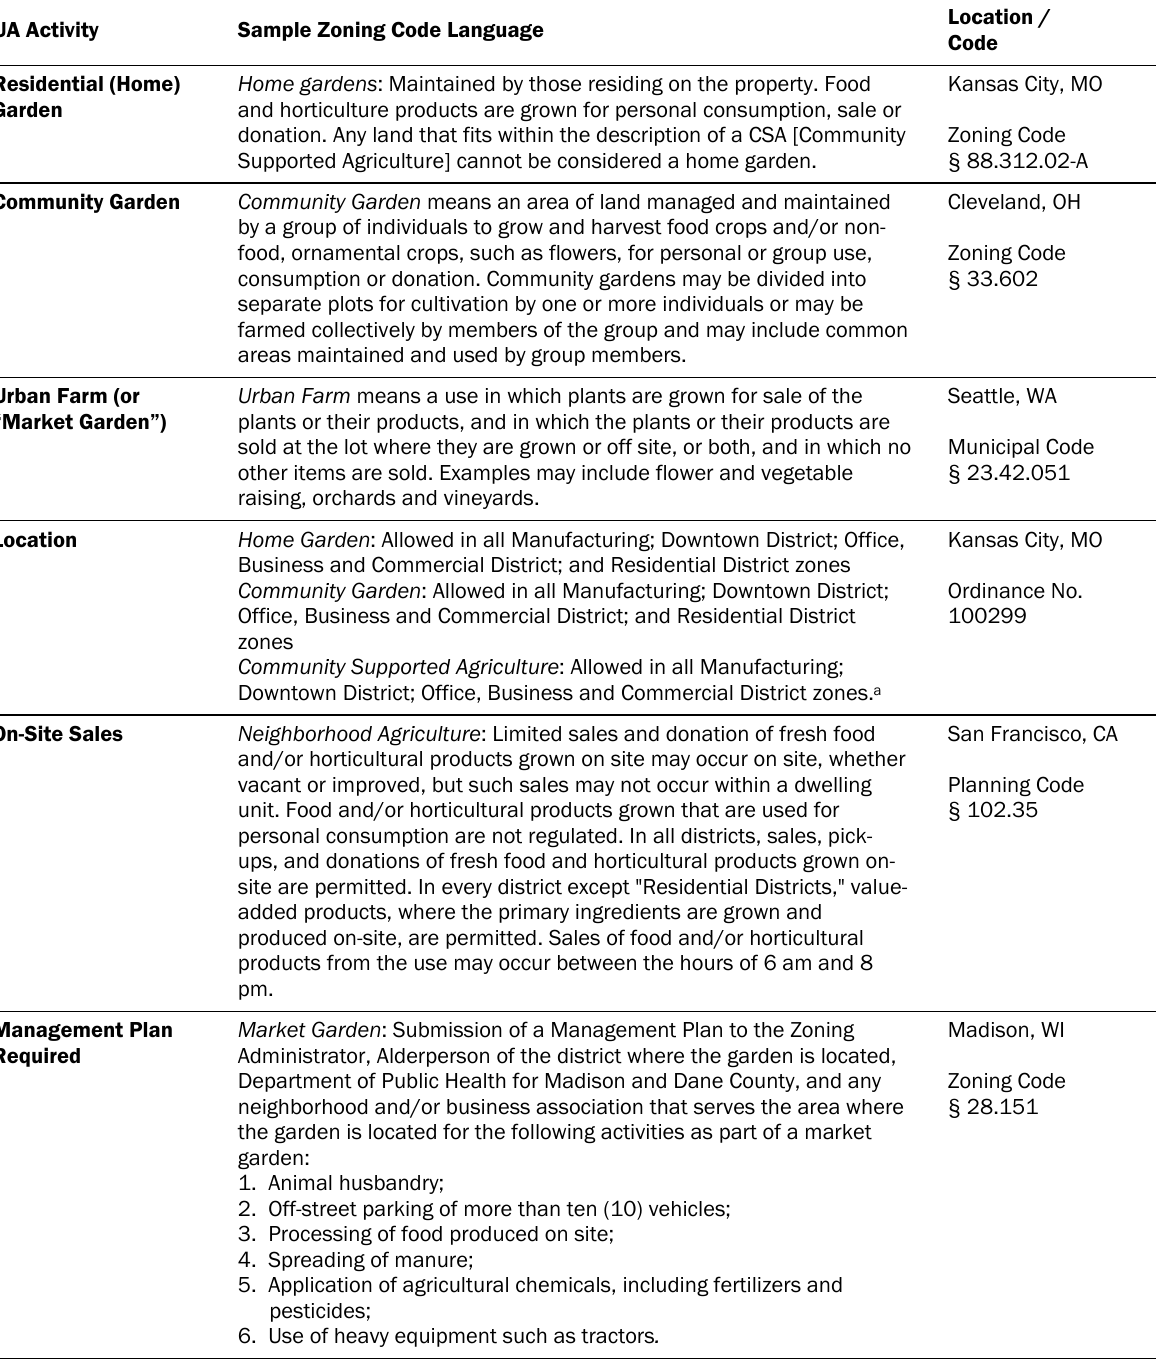
Table 1. Examples of Urban Agriculture Zoning Best Practices UA